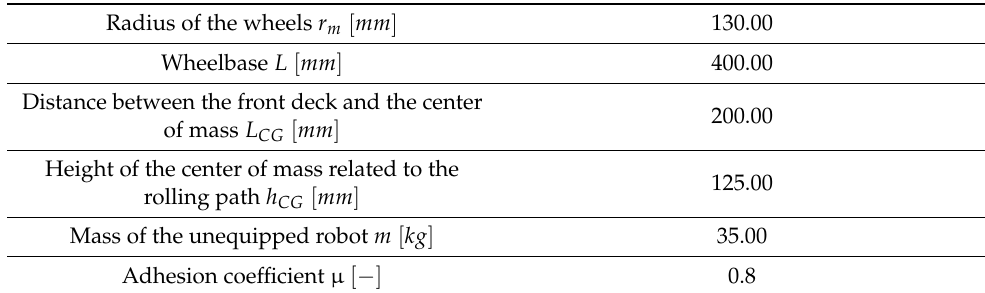
Table A1. The characteristics of the robot used for the